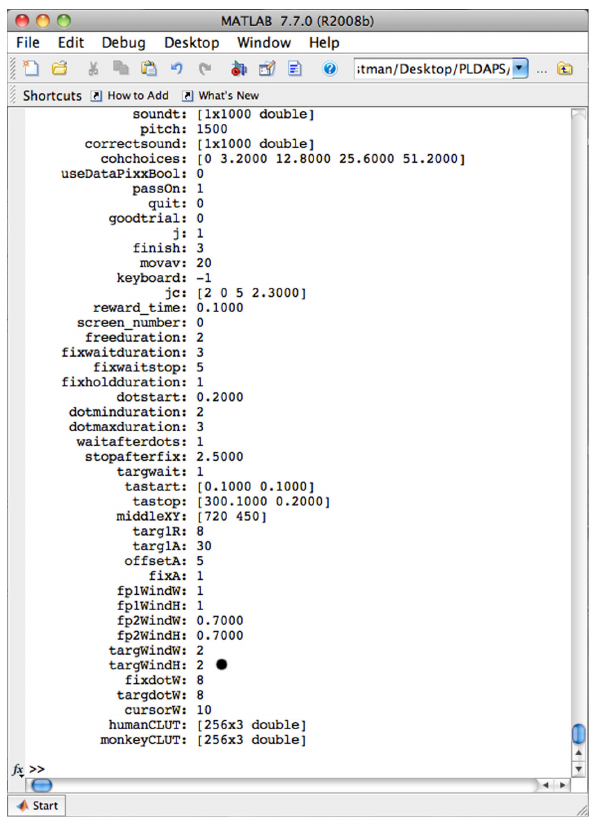
FIGURE 2 | CommandWindow User Interface. The condition structure is displayed in the command window at the end of each trial, clearly displaying all necessary information. On-the-fly changes to individual fields are made by pressing “p” (for pause), which keyboard access.Typing return will continue the experiment.